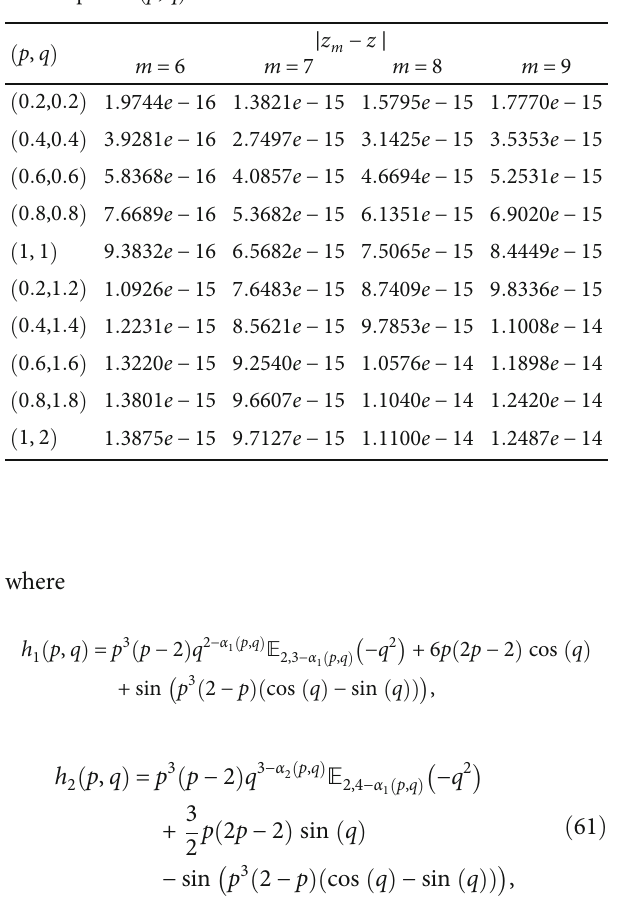
Table 4: The absolute error for di ff erent values m for Example 8 at various points ð p , q Þ .